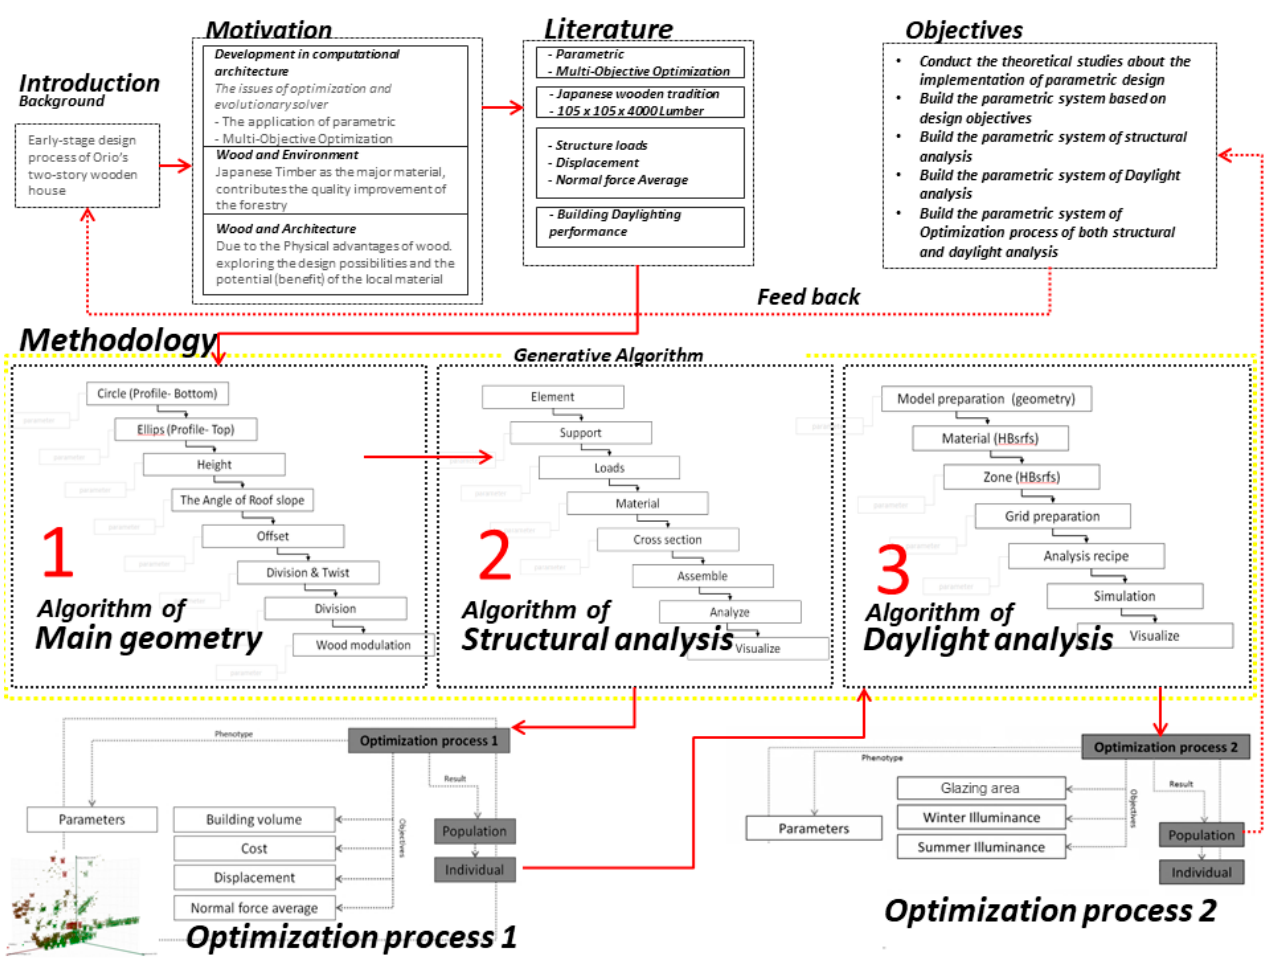
Figure 3. Research framework .